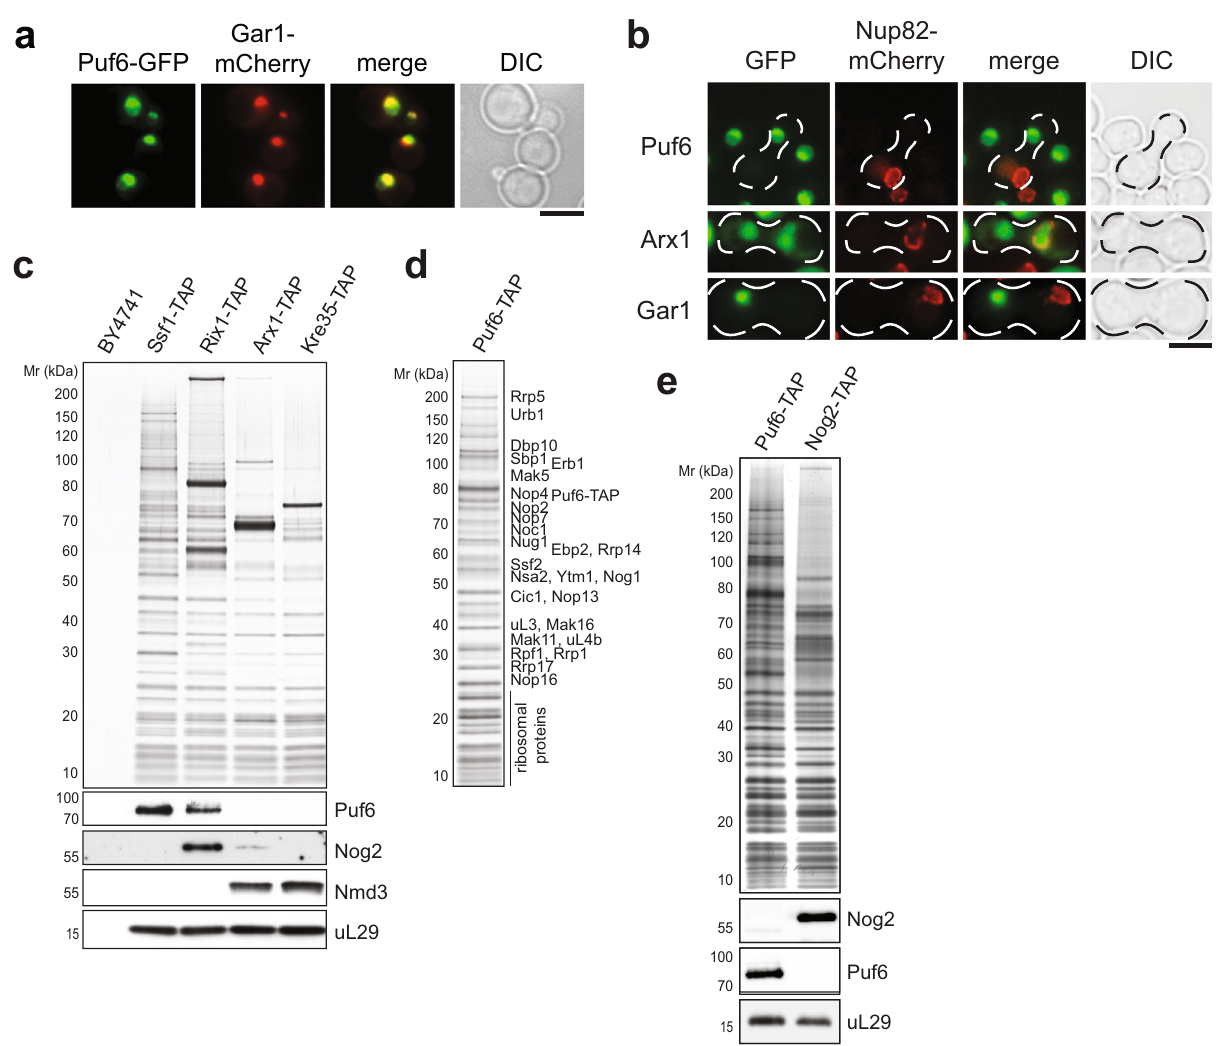
Fig. 3 Puf6 is enriched in the nucleolus and associates with early 60S pre-ribosomes. a Yeast cells expressing Puf6-GFP and the nucleolar marker Gar1- mCherry were grown to mid-log phase in YPD and then analyzed by fl uorescence microscopy. Scale bar = 5 µ m. b Cells expressing Puf6-GFP, Arx1-GFP, or Gar1 – GFP were mated with a kar1-1 strain expressing Nup82-mCherry. The resulting heterokaryons were analyzed by fl uorescence microscopy. Arx1-GFP and Gar1 – GFP serves as a positive and negative control for the shuttling assay, respectively. Scale bar = 5 µ m. c TAP-eluates of the early to late 60S pre- ribosomes isolated via the indicated TAP-baits were separated on a NuPAGE 4 – 12% Bis-Tris gradient gel and subjected to Silver staining or Western blotting using antibodies directed against Puf6, Nog2, and Nmd3. The r-protein uL29 (yeast Rpl35) served as a loading control. WT-BY4741 (untagged strain) served as the negative control. d The Puf6-TAP particle was separated on a NuPAGE 4 – 12% Bis-Tris gradient gel and analyzed by Silver staining. The indicated proteins were identi fi ed by mass spectrometry. e Puf6-TAP and Nog2-TAP eluates were separated on a NuPAGE 4 – 12% Bis-Tris gradient gel and subjected to Western blotting using the indicated antibodies. The r-protein uL29 (yeast Rpl35) served as a loading control. Source data are provided as a Source Data fi